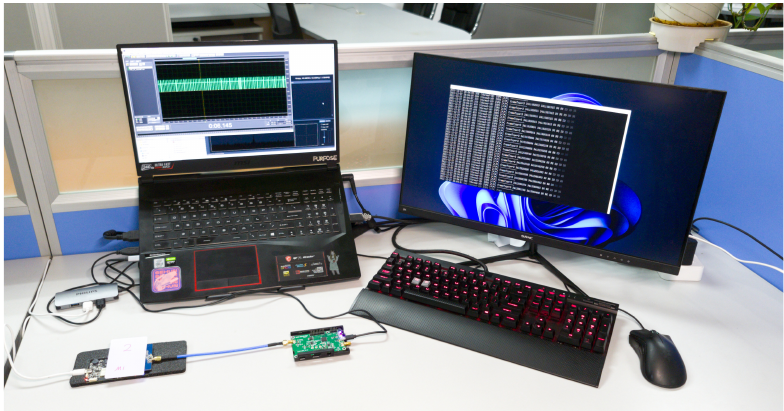
Figure 1. The measurement setup for NFC signal